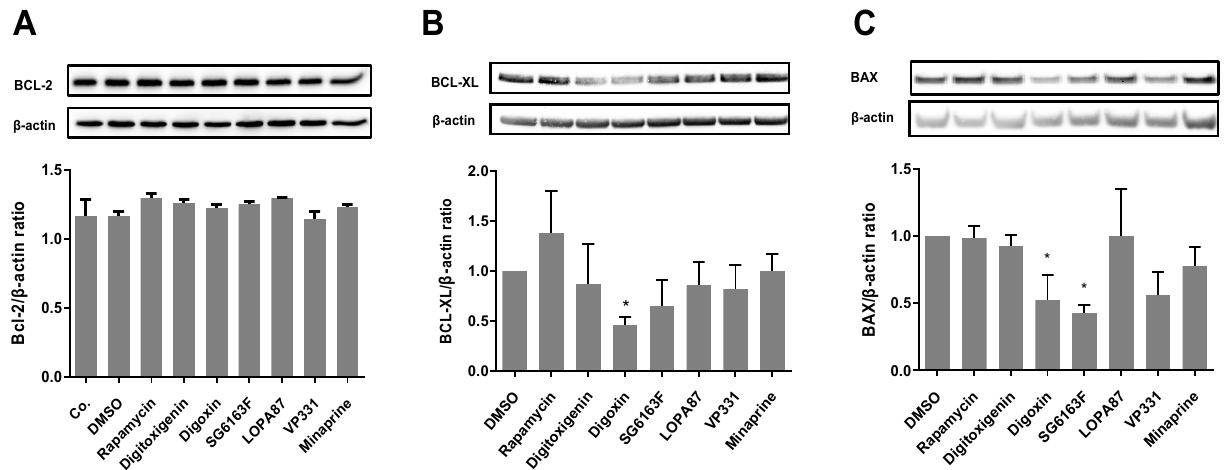
Figure 3. Effects of selected compounds on the expression of pro- and anti-apoptotic members of Bcl-2 family. Protein expression levels of BCL-2 ( A ), BXL-XL ( B ), and BAX ( C ) in RNVCs cultured for 6 h with indicated compounds. β -actin was used as a loading control. Co.—control of untreated cells. Representative Western blot images and quantification of three independent experiments are presented as mean ± SEM with one-way ANOVA, Sidak’s multiple comparisons test. *, p < 0.05 vs. DMSO.